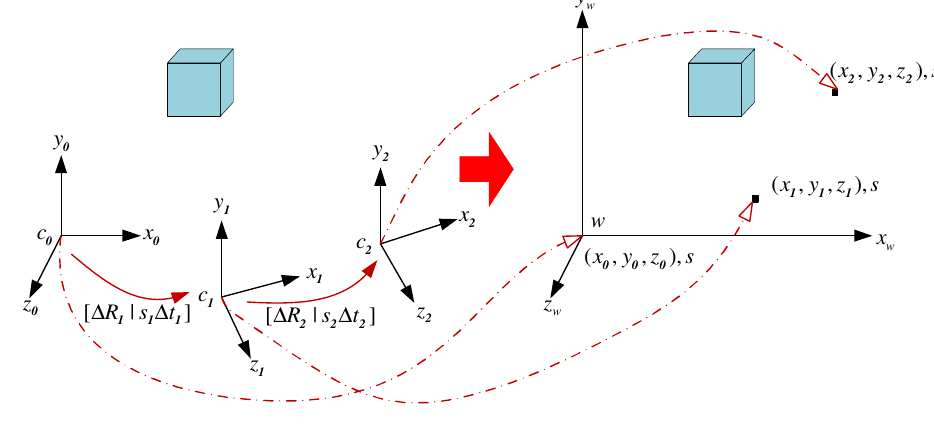
Figure 8. Unified scale recovery from